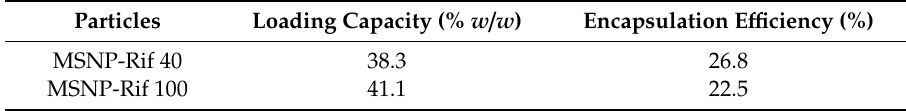
Table 2. Loading capacity and encapsulation e ffi ciency of rifampicin into MSNP.